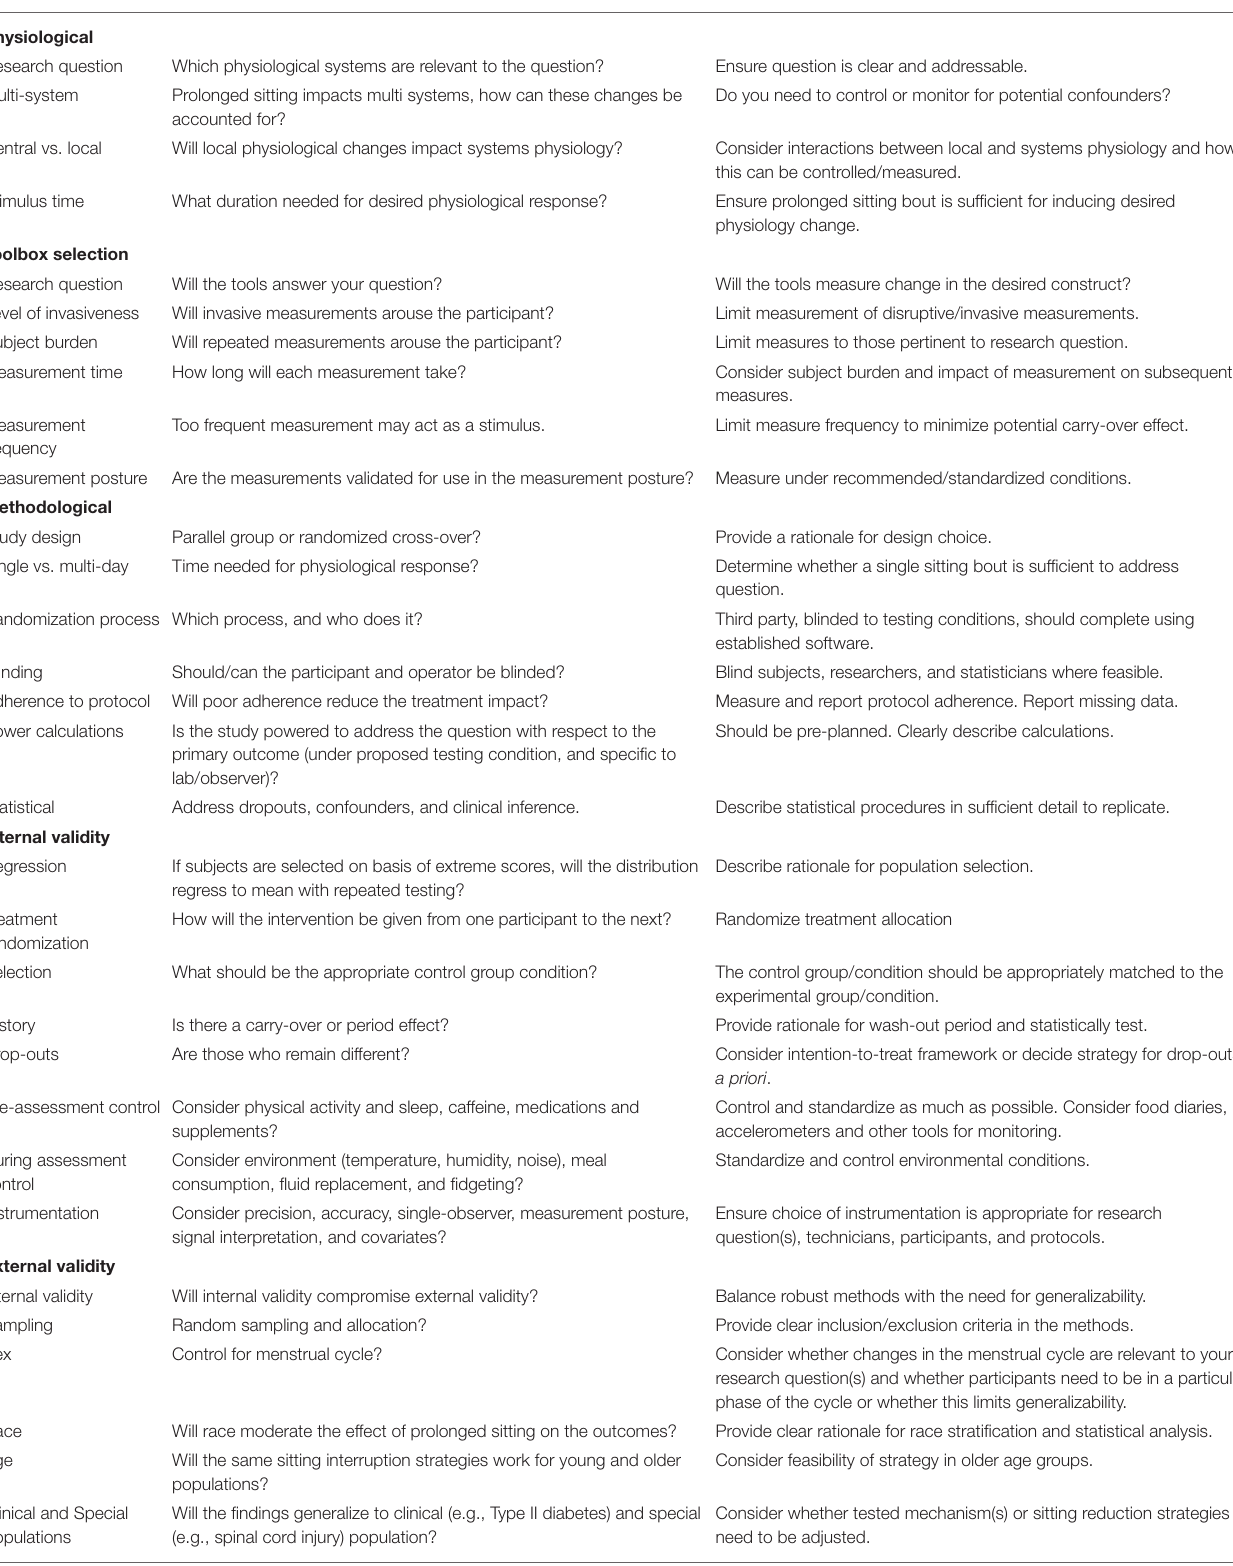
TABLE 3 | Measurement considerations for studies investigating the effect of acute sitting exposure on the cardiovascular system. Consideration Example(s)